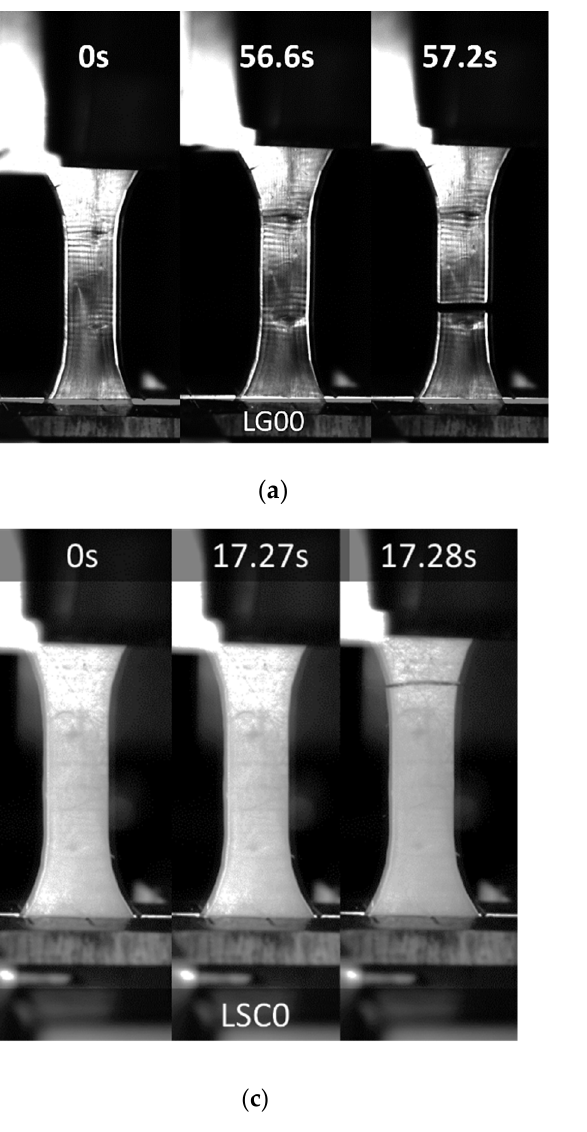
LC00, ( c ) LSC0, ( d ) LSFC. ( c ) LSC0, ( d )